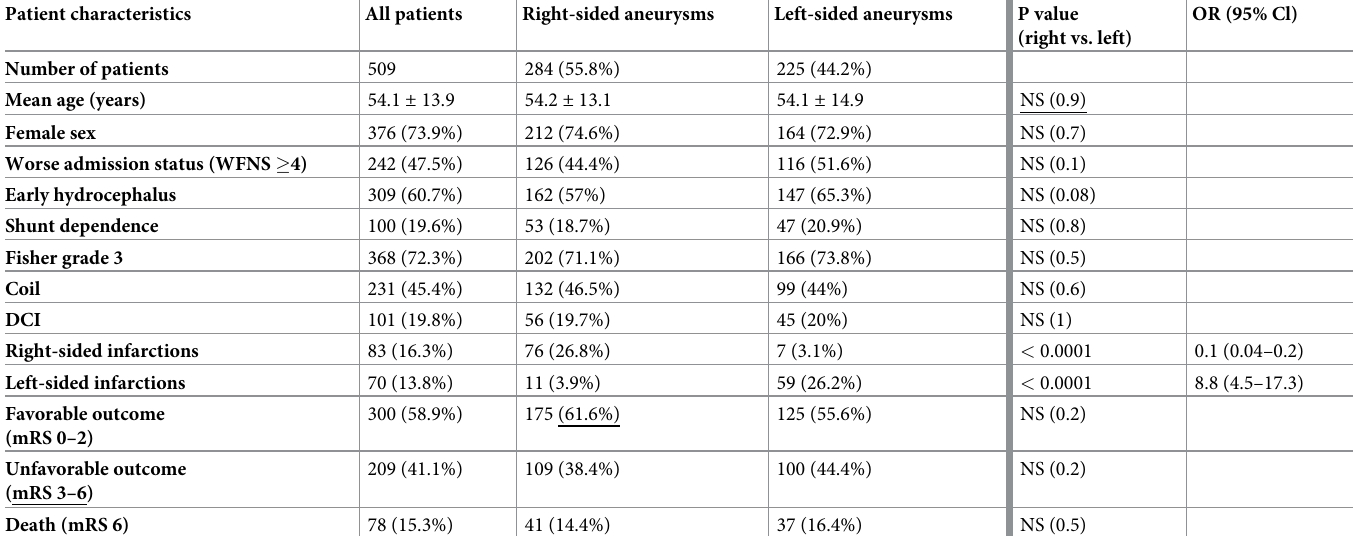
Table 1. Patient characteristics.